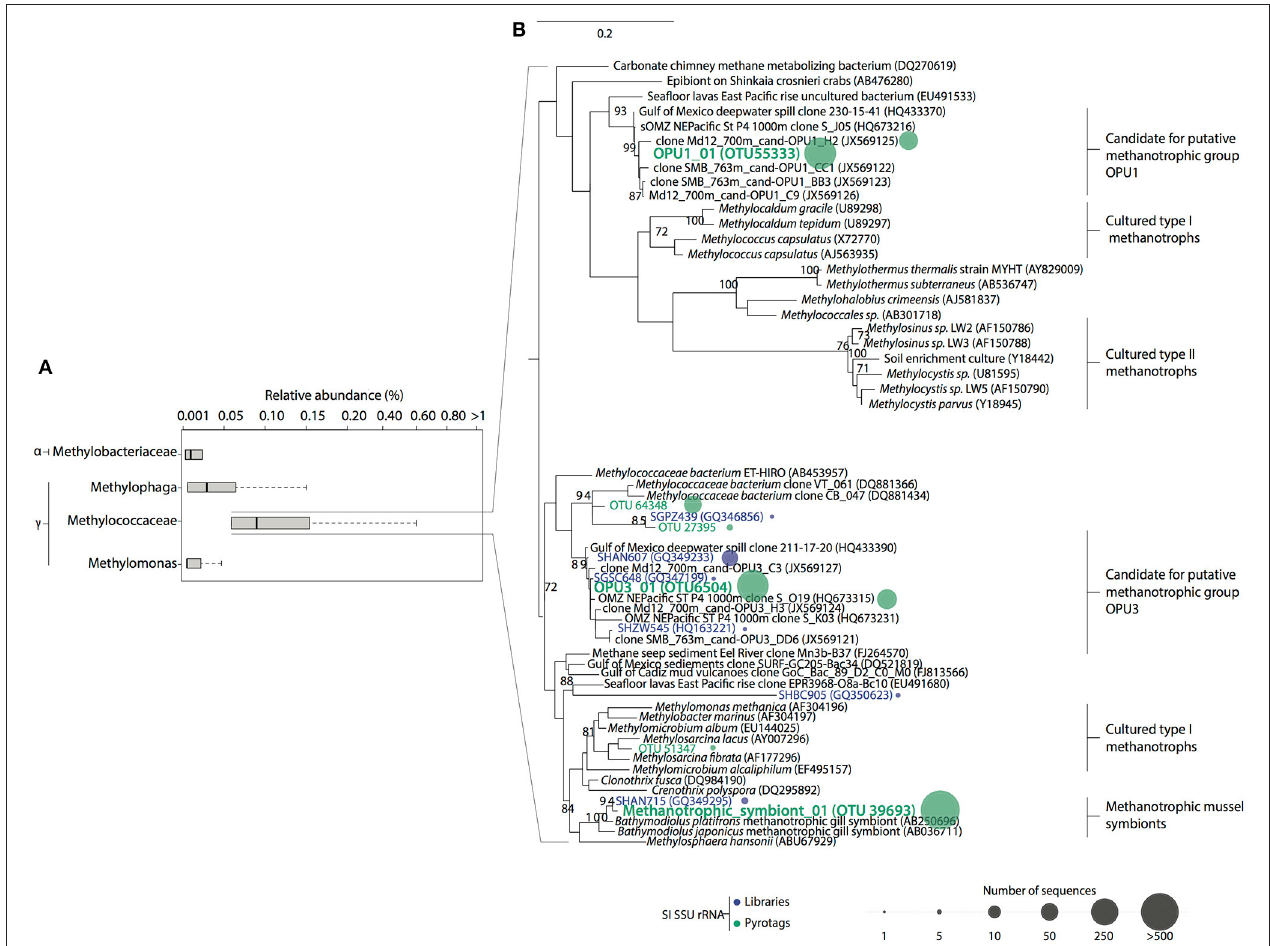
FIGURE 3 | Relative abundance and phylogenetic relationships between Type I and Type II methanotroph OTUs in Saanich Inlet. (A) Rare ( < 1% relative abundance) methanotrophic and methylotrophic taxa found in SSU rRNA gene pyrotag dataset. The size of each box represents the average of relative abundance ( > 0.01%) calculated from the total number of prokaryotic reads throughout the water column over this period. Extended dashed lines (whiskers) represent at the base the lower and upper quartiles (25 and 75%) and at the end the minimum and maximum values encountered. The middle line represents the median. (B) Tree inferred using maximum likelihood implemented in PHYML. The percentage ( ≥ 70%) of replicates in which the associated taxa clustered together in the bootstrap test (1000 replicates) is shown next to the branches. Reference sequences for lineages are shown in black. Representative sequences obtained from Saanich Inlet SSU rRNA gene libraries clustered at 97% similarity are shown in blue. OTUs representative sequences (97% similarity) from pyrotag datasets taxonomically identified as methanotrophs are shown in green. Sequences abundance is depicted by colored circles whose circumference indicated the total number of sequences (reads) within the